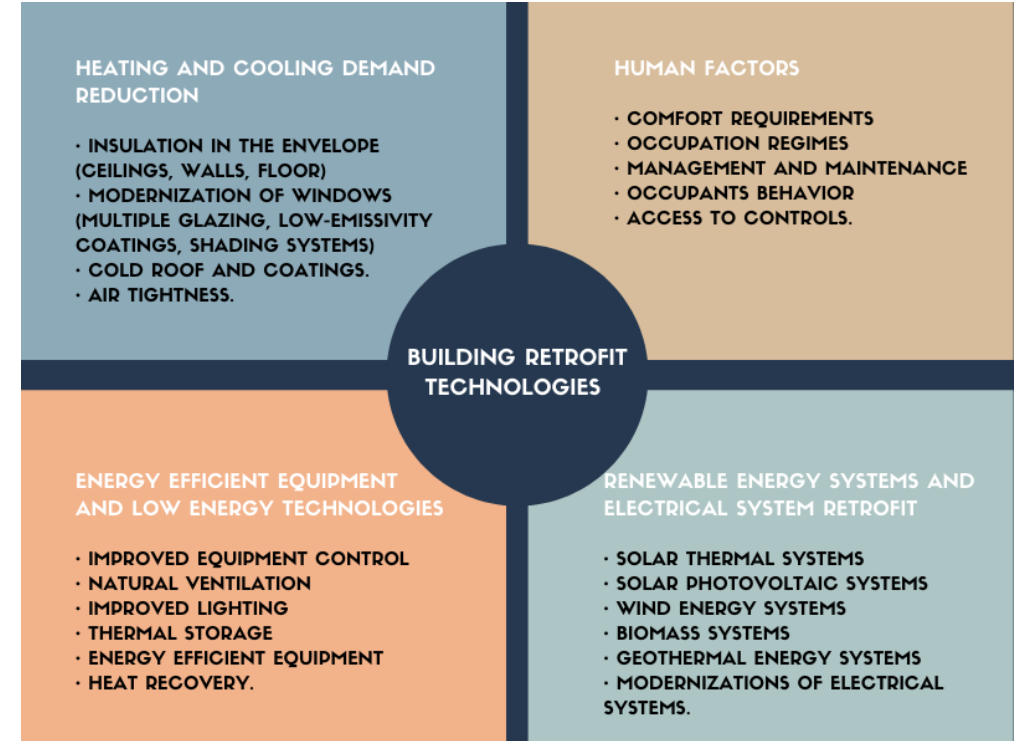
Figure 1. Categories of building retrofit technologies according to [15]. Reprinted with permission from ref. [15]. 2022 Elsevier B.V.